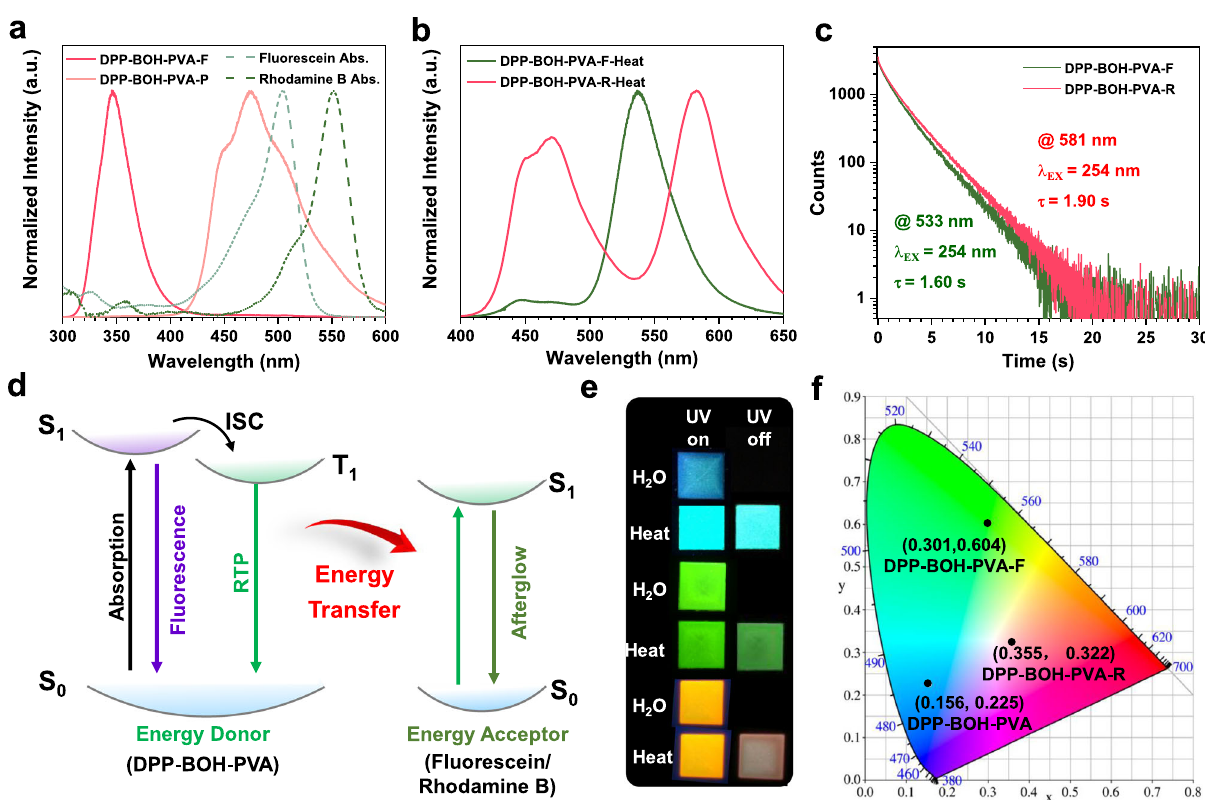
Fig. 4 Tunable afterglow color through triplet-to-singlet Förster-resonance energy transfer (TS-FRET). a The fl uorescence/phosphorescence spectra of DPP-BOH-PVA and the UV – vis absorption spectra of fl uorescein and rhodamine B. b The normalized RTP spectra of DPP-BOH-PVA-F and DPP-BOH-PVA- R. c Time-resolved emission-decay pro fi les of DPP-BOH-PVA-F (@ 533 nm) and DPP-BOH-PVA-R (@ 581 nm). d Simpli fi ed Jablonski diagram to explain the phosphorescence energy transfer (ISC = intersystem crossing, RTP = room-temperature phosphorescence). e RTP photographs of DPP-BOH-PVA, DPP-BOH-PVA-F, and DPP-BOH-PVA-R before and after heating at 90 °C for 15 min. f Commission Internationale de l ’ Eclairage (CIE) coordinates of afterglow emissions for DPP-BOH-PVA, DPP-BOH-PVA-F, and